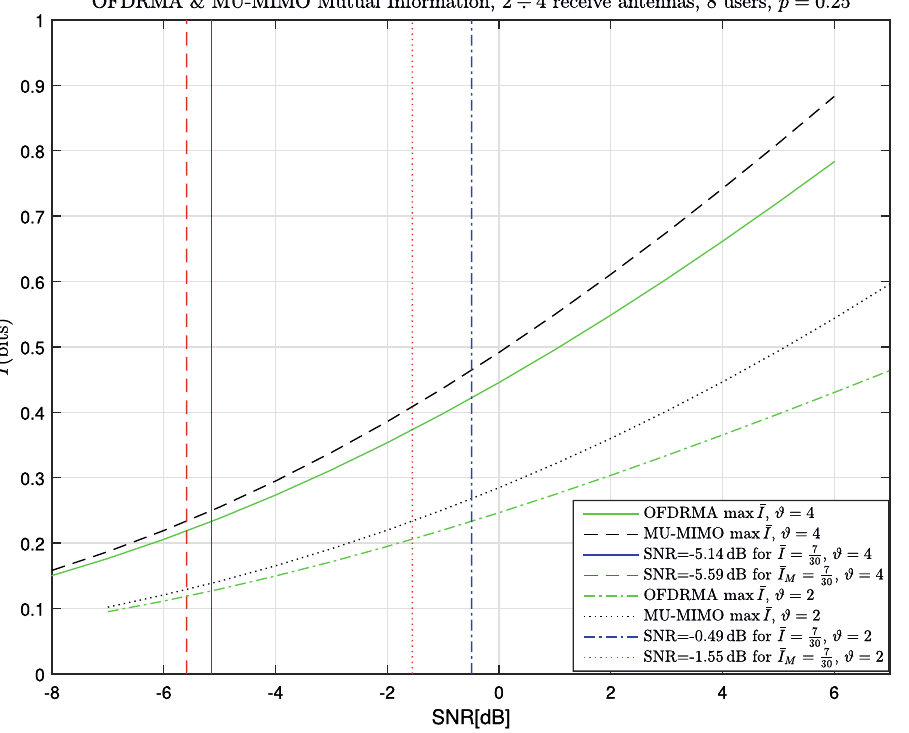
Figure 4. OFDRMA & MU-MIMO comparison of Mutual Information vs SNR, p = 0.25 , ϑ = 2 ÷ 4 , u = 8